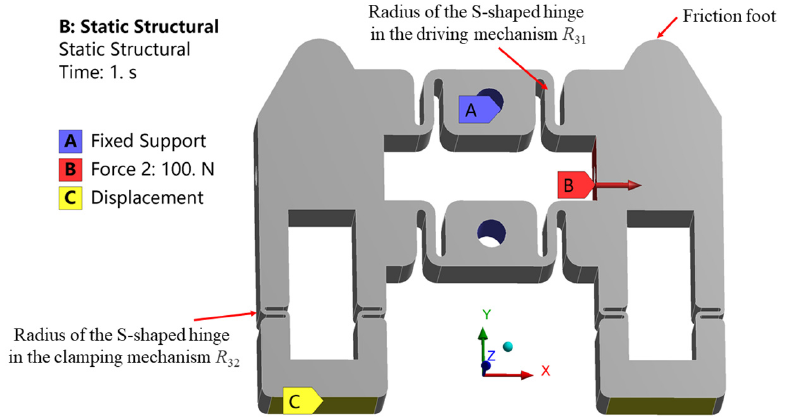
Figure 3. Boundary conditions for simulation of the stator.